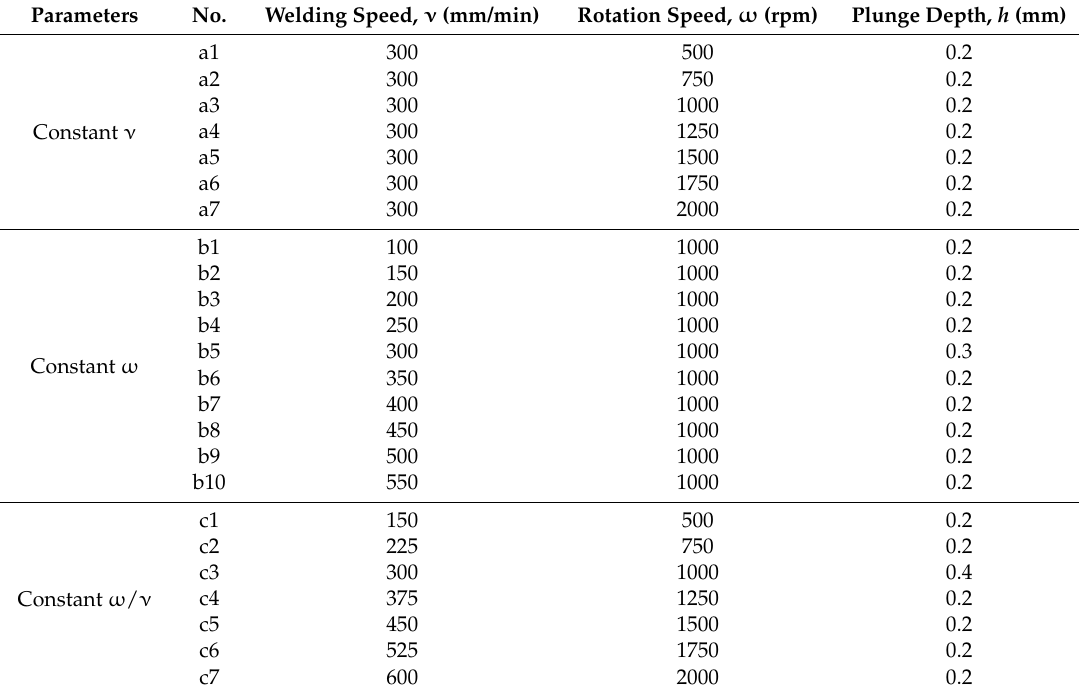
Table 1. Experimental parameters used to get appropriate parameters.